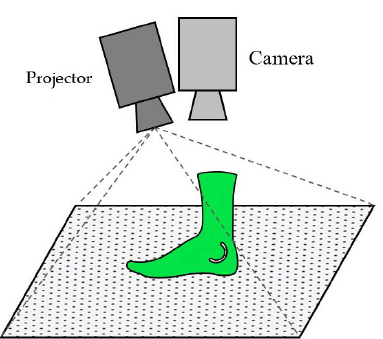
Figure 1. Operating principle of SL cameras with pattern